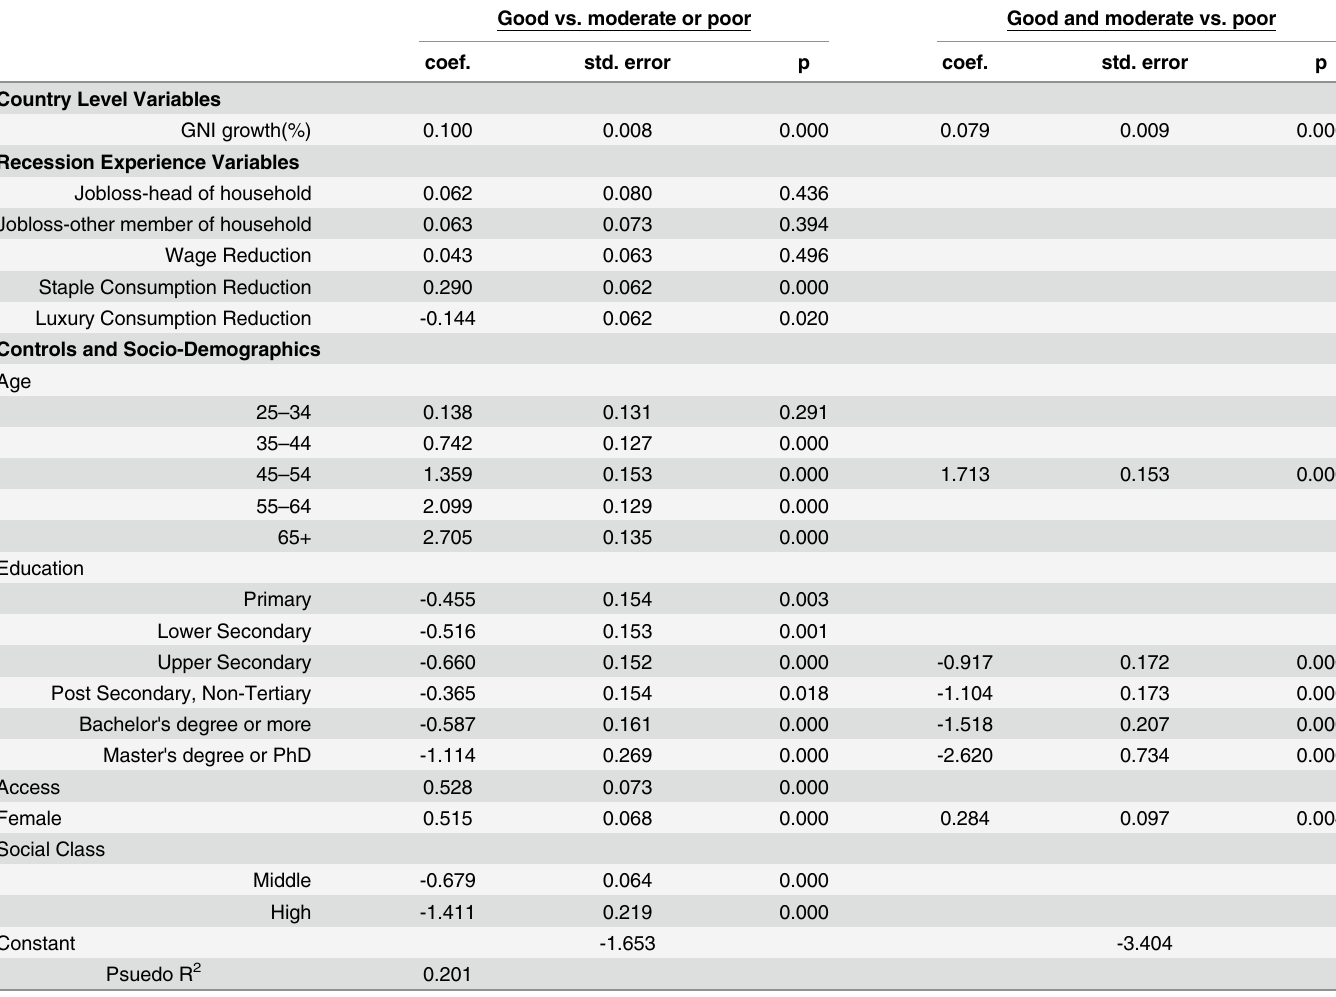
Table 6. Weighted Partial Proportion Odds Model of Self-Rated Health, First GNI per capita quartile ($1820-$4640). Good vs. moderate or poor Good and moderate vs. poor coef.